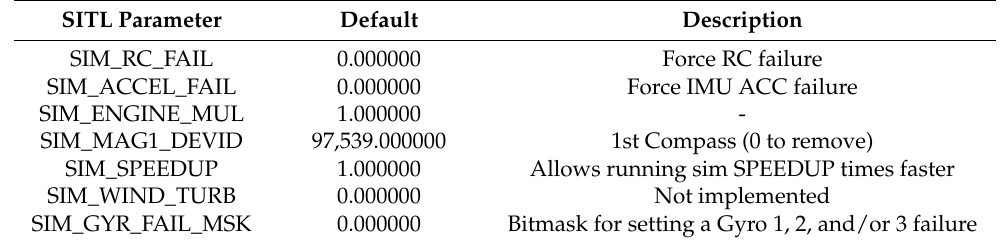
Table 2. Parameter configuration of the simulator.